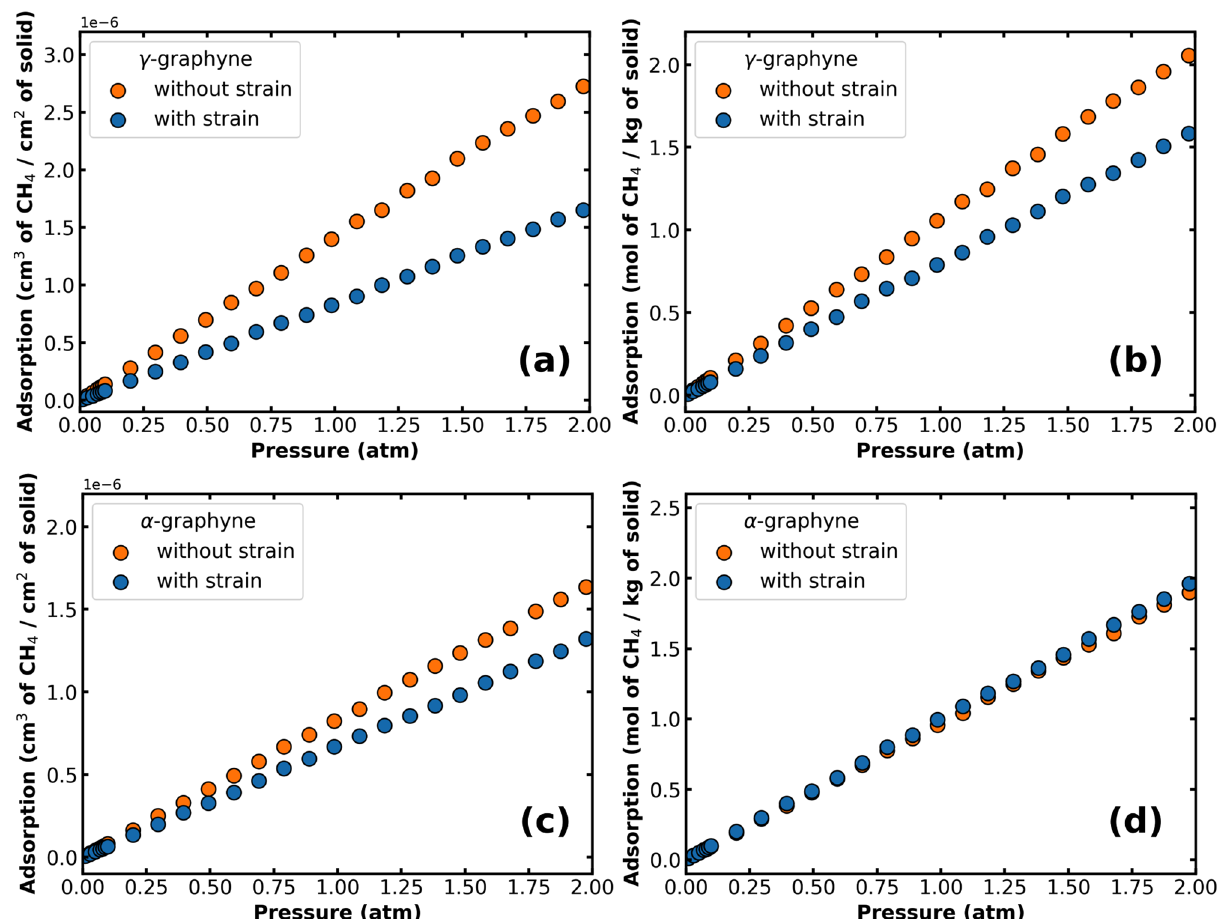
Figure 5. Adsorption isotherms of CH 4 on ( a , b ) γ -graphyne and ( c , d ) α -graphyne, comparing results with and without strain and considering different adsorption units (T = 298